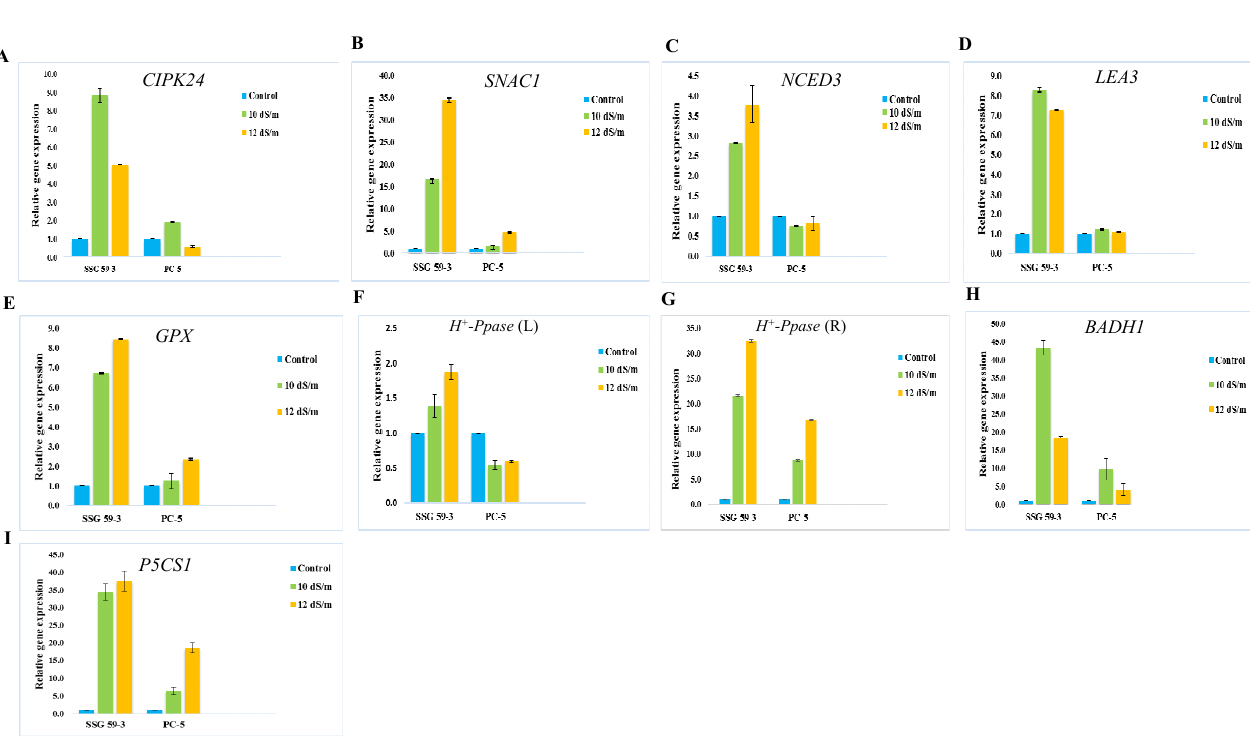
Figure 18. The expression levels ( A – I ) of stress ‐ related marker genes of 10 selected DEGs based on qPCR. The PP2A gene was used as the reference gene/internal control. Data are shown as mean ± S.D. (n = 3).